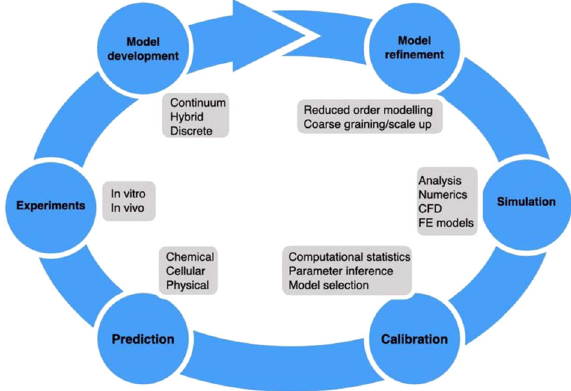
Fig. 2 Methodology. An illustrative diagram showing the quanti- tative regenerative medicine pipeline with stages of the modelling process and types of modelling